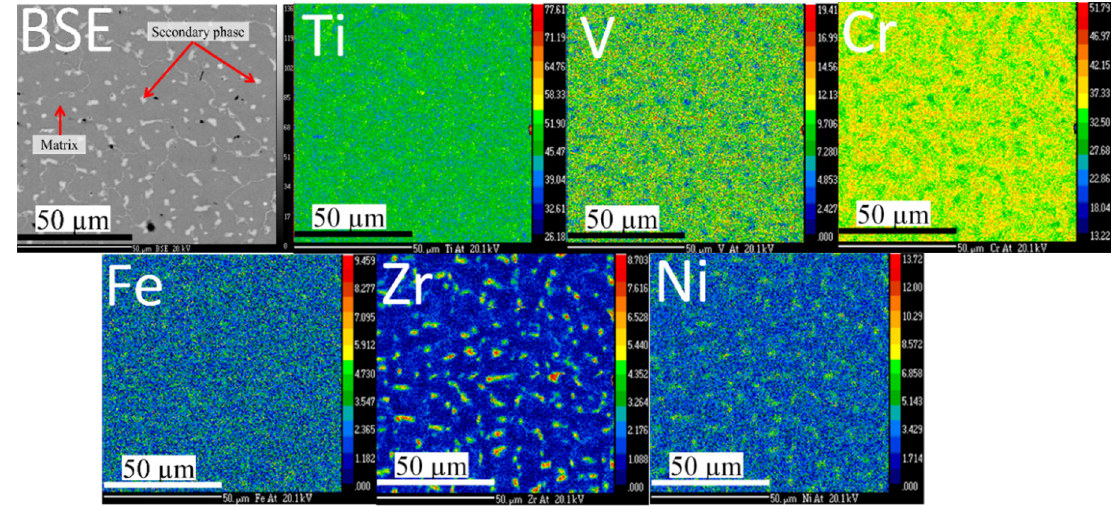
Figure 1. Backscattered micrograph and elements mappings of the as-cast co-melt Ti 1.56 V 0.18 (FeV) 0.18 Cr 1.08 + 4% Zr 7 Ni 10 alloy.